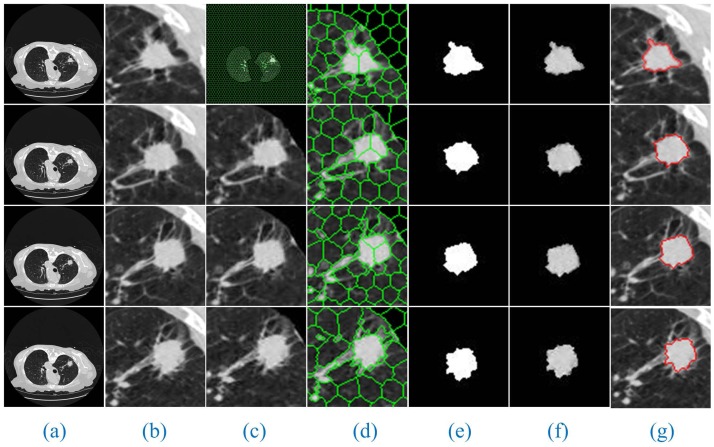
The sequence segmentation results of our method for juxta-vascular nodules.The detailed descriptions are the same as in Fig 5.